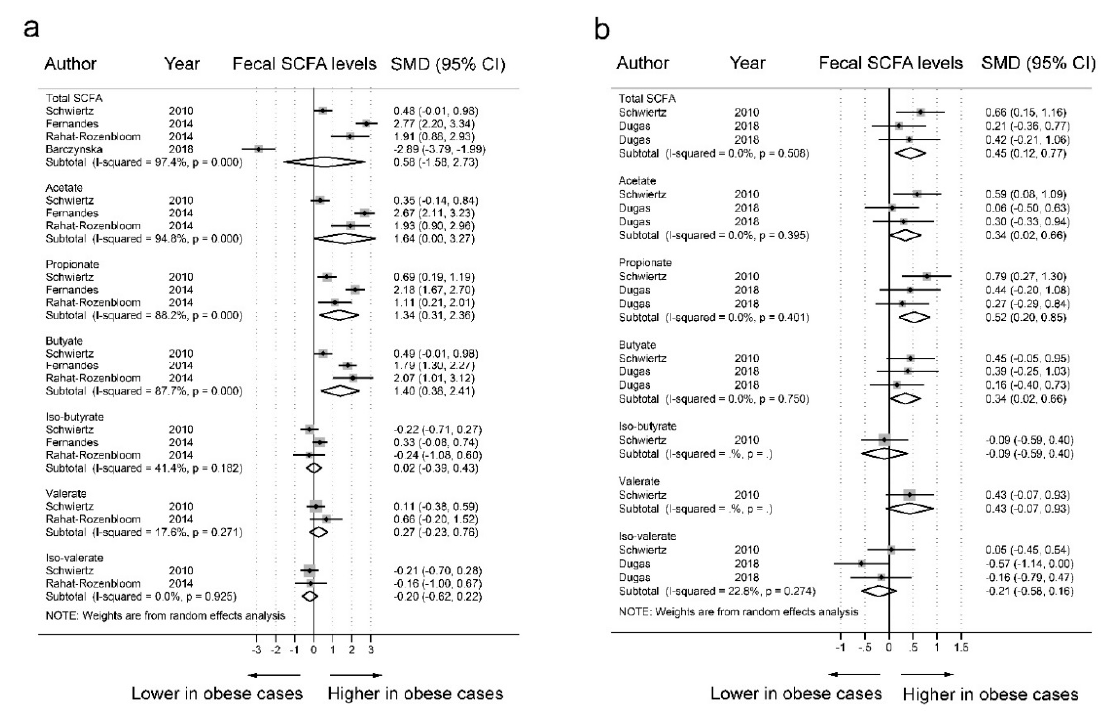
Figure 4. Subgroup analyses of the fecal short-chain fatty acid (SCFA) levels in obese and nonobese individuals. a . Forest plots of 20 data sets of SCFA levels in obese cases (BMI >25kg/m 2 ) and nonobese controls (BMI <25kg/m 2 ); b . Forest plots of 17 datasets of SCFA levels in obese cases (BMI >30kg/m 2 ) and nonobese controls (BMI <25kg/m 2 ). The combined standardized mean differences (SMDs) and 95% confidence intervals (CIs) were calculated using random effects models.